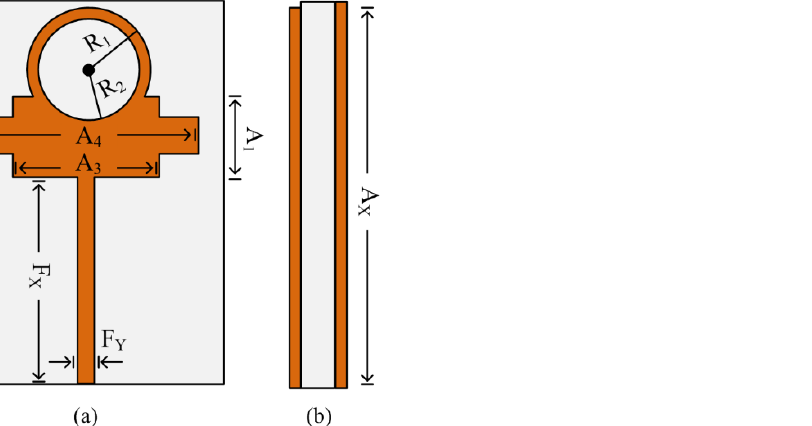
Figure 1. Geometrical structure of the proposed wideband millimeter-wave antenna: ( a ) top view; ( b ) side view.